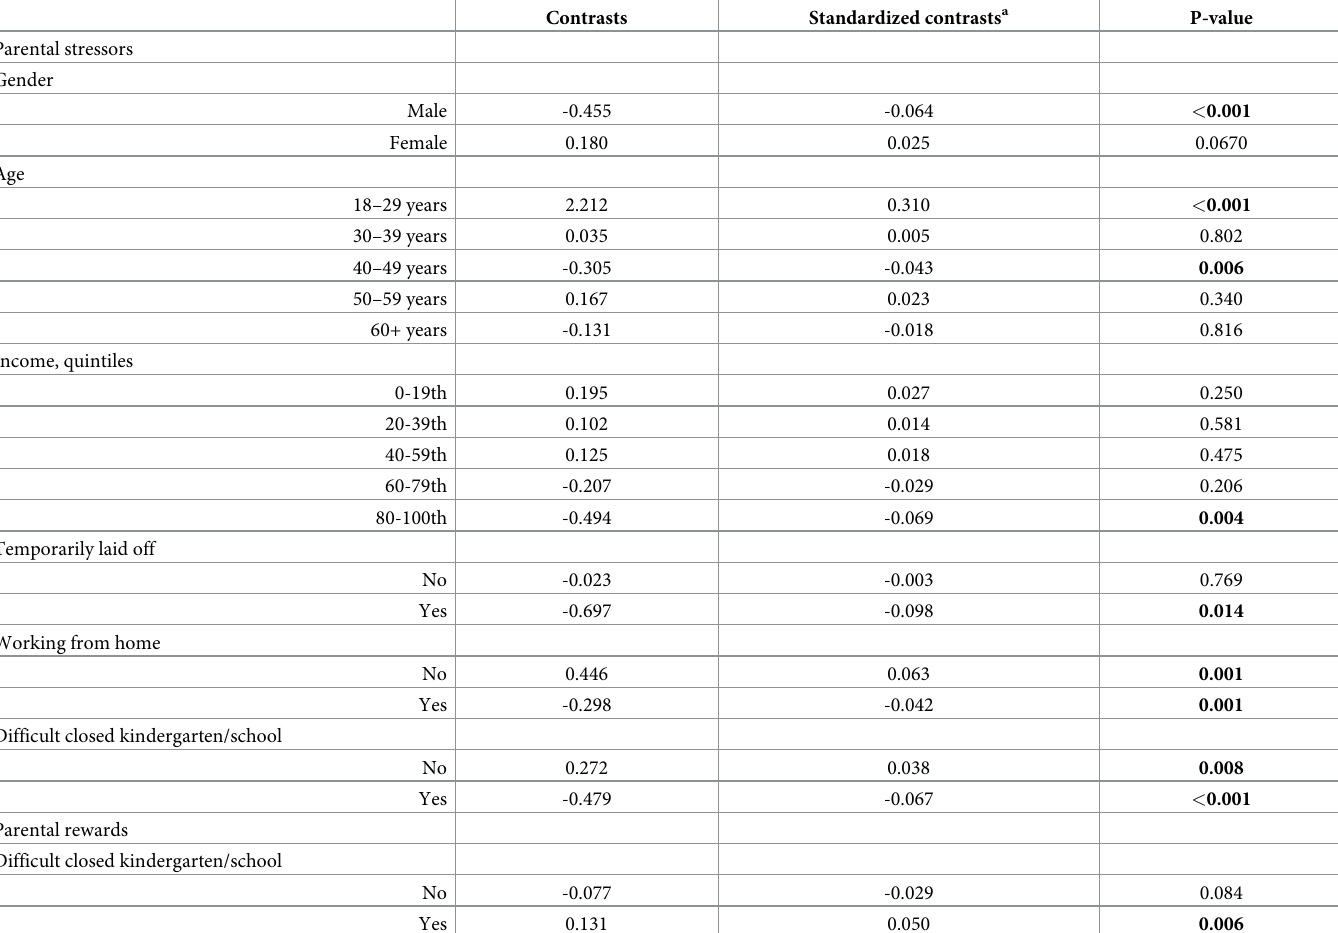
Table 4. Stratified results for parental stressors and parental rewards. Contrasts of marginal linear predictions: time point 2 compared to time point 1. Separate stratifi- cation for each